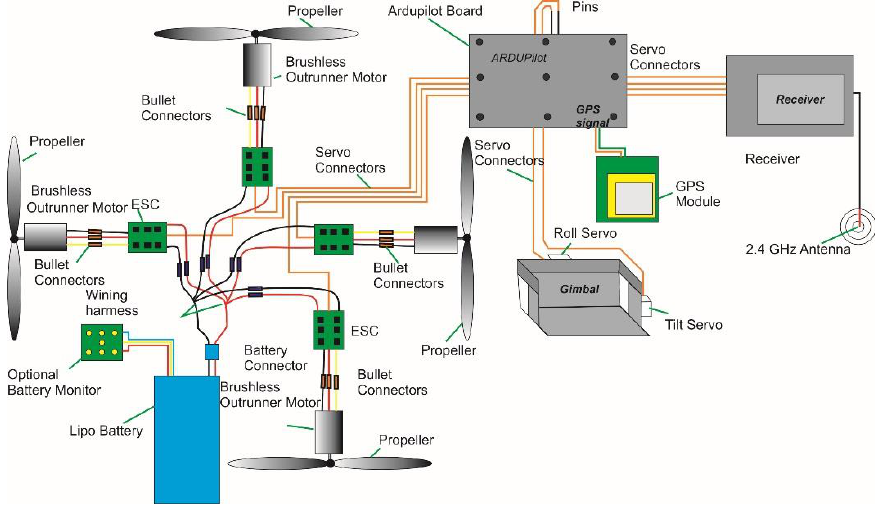
Figure 2. Wiring diagram of quadcopter basic components (based on Reference [45]) .